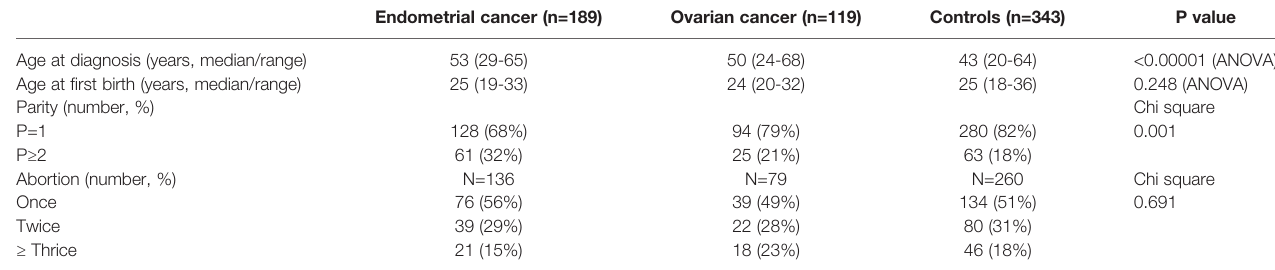
TABLE 1 | Clinical characteristics of study population.